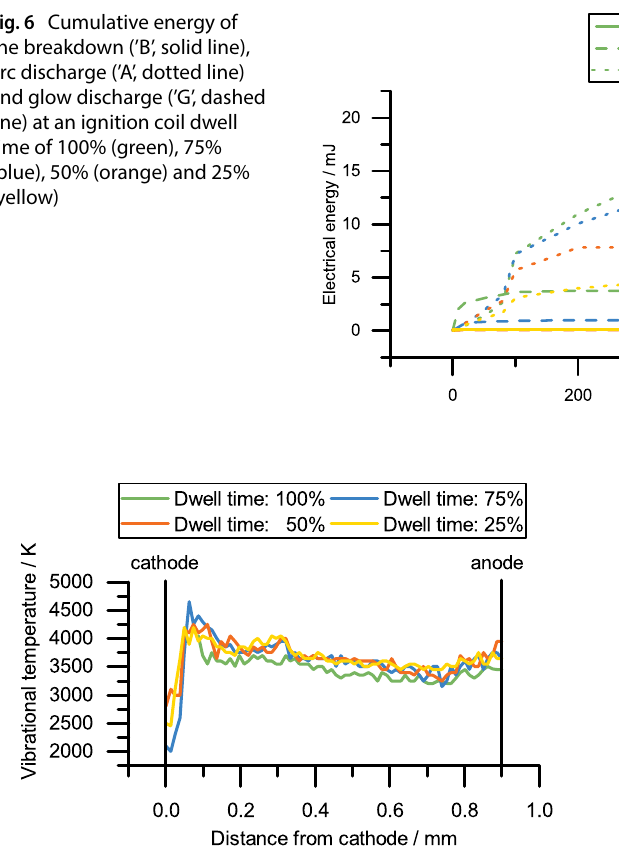
Fig. 7 Vibrational temperature during the breakdown depending on the distance to the cathode